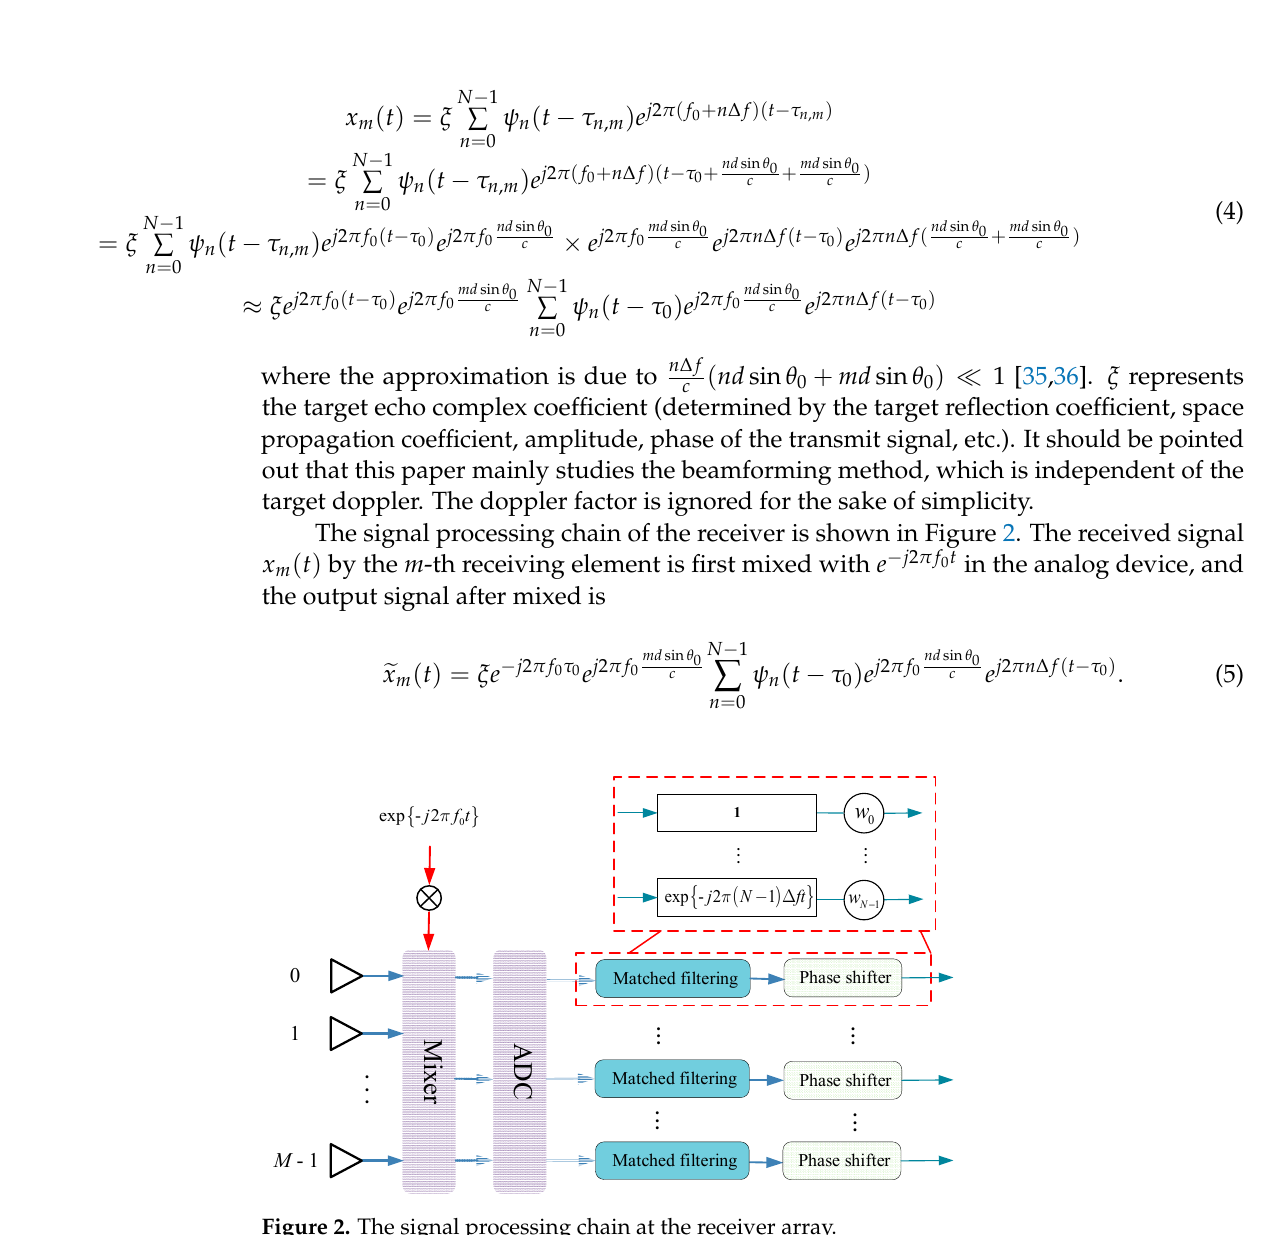
Figure 2. The signal processing chain at the receiver array.